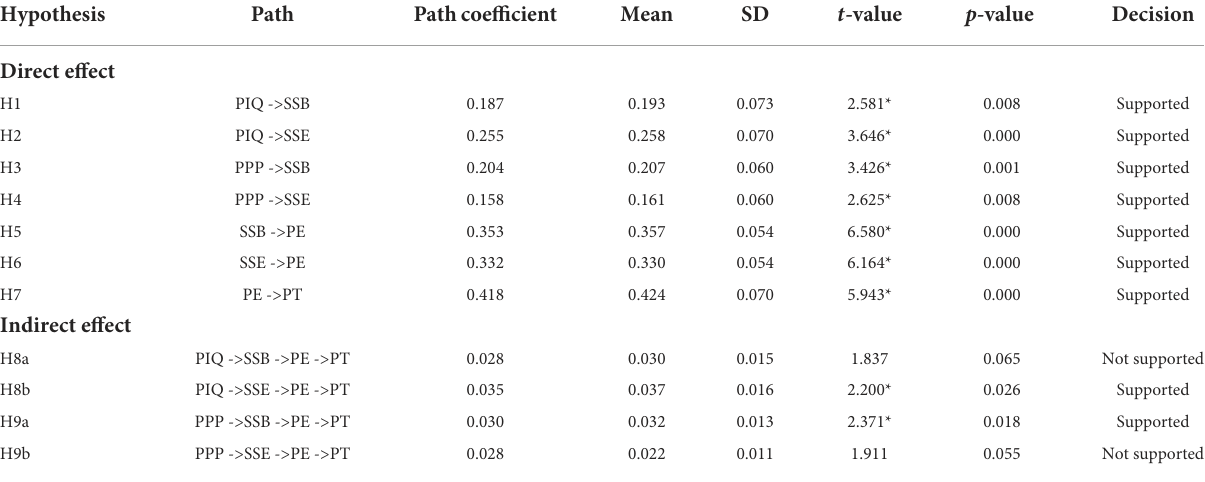
TABLE 5 Hypothesis testing and strength of the